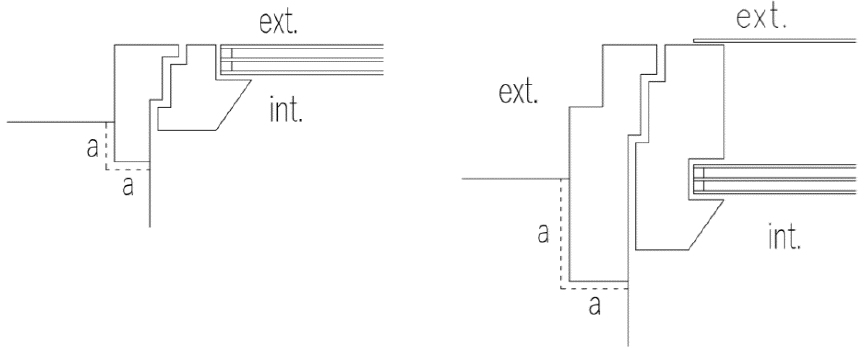
Figure 5. Configuration A ( left ) and alternative configuration B ( right ) that were tested in parametric studies. a : adiabatic condition [23].